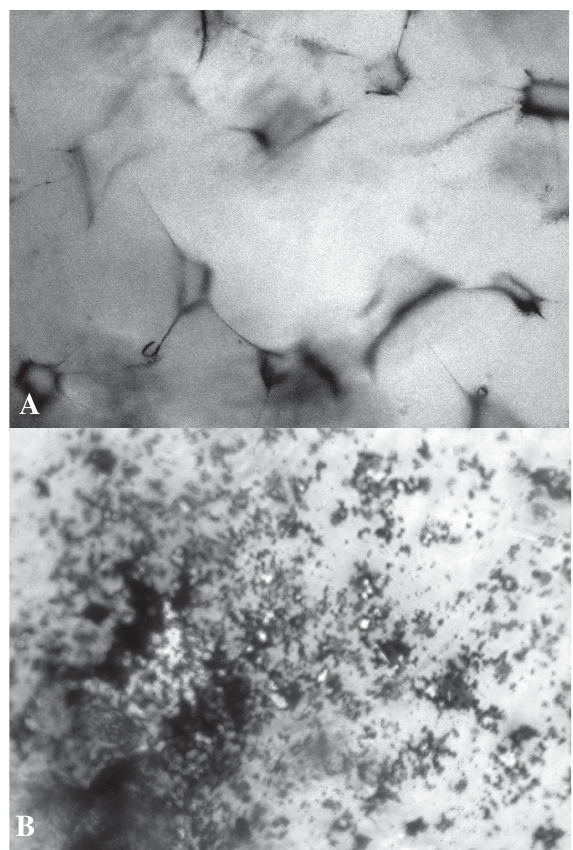
Fig. 4 A, B. Von Kossa staining showed spots of dark brown coloration (Production of bone nodules by the osteogenic cells seeded onto A)scaffolds and B)cultured on the plate)